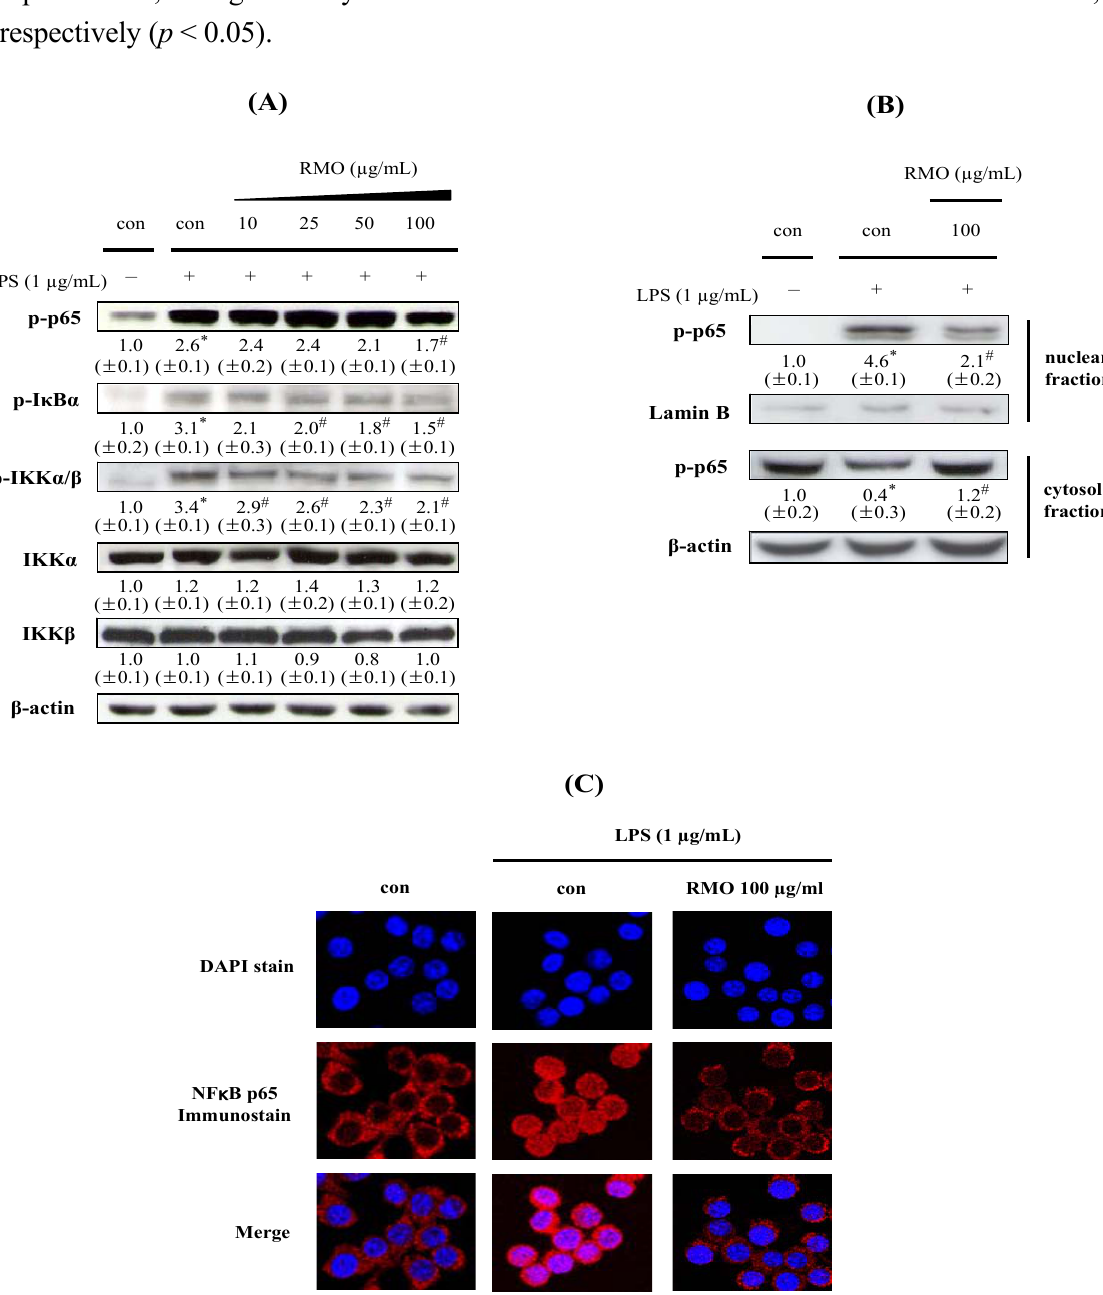
Figure 4. RMO suppresses NF κ B activation by blocking NF κ B p65 nuclear